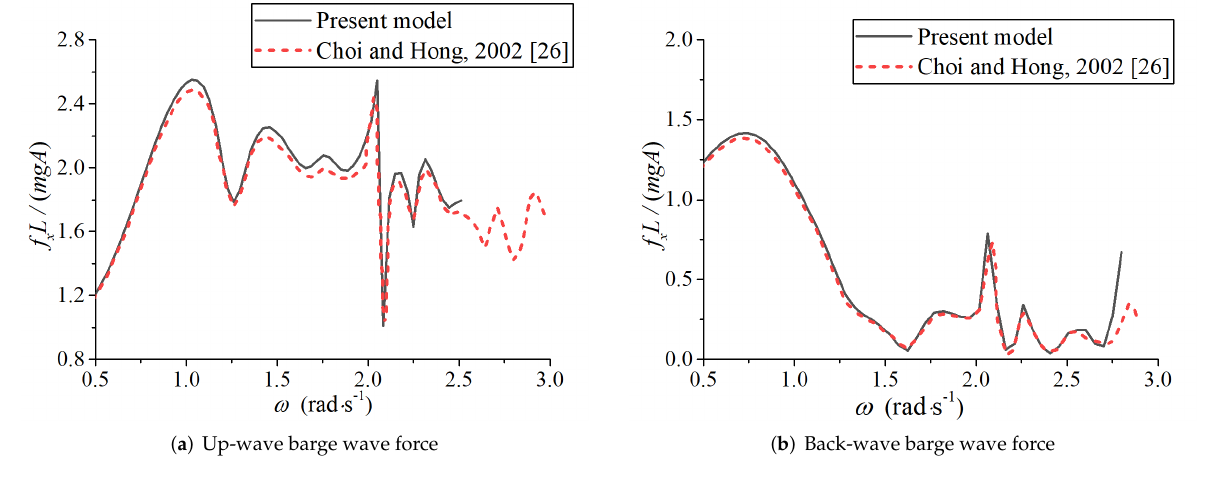
Figure 4. Wave forces of barges in the surge direction: ( a ) up-wave barge; ( b ) back-wave barge [26].